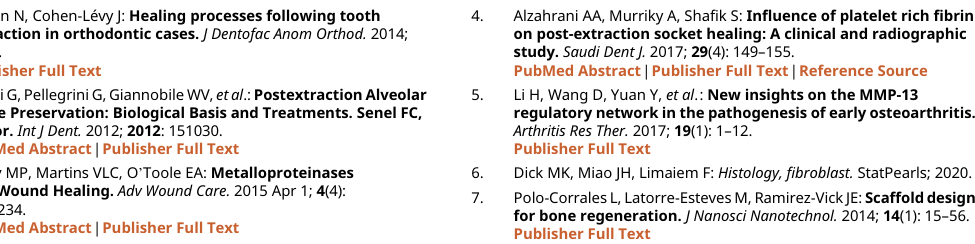
= Table 1 (Table of histoscore difference of MMP-13 between groups) = Table 2 (Table of differentiation of each treatment groups by observation times on Day 3, Day 7, and Day 14) Data are available under the terms of the Creative Commons Zero “ No rights reserved ” data waiver (CC0 1.0 Public domain